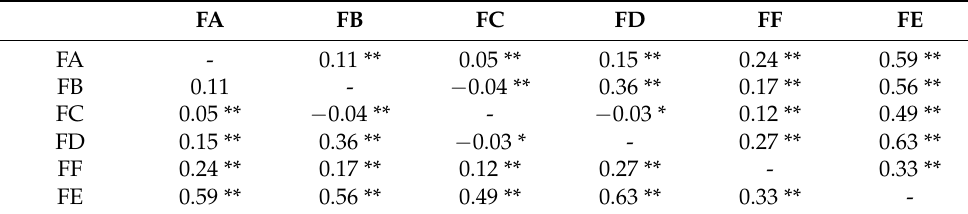
Table 3. Correlation